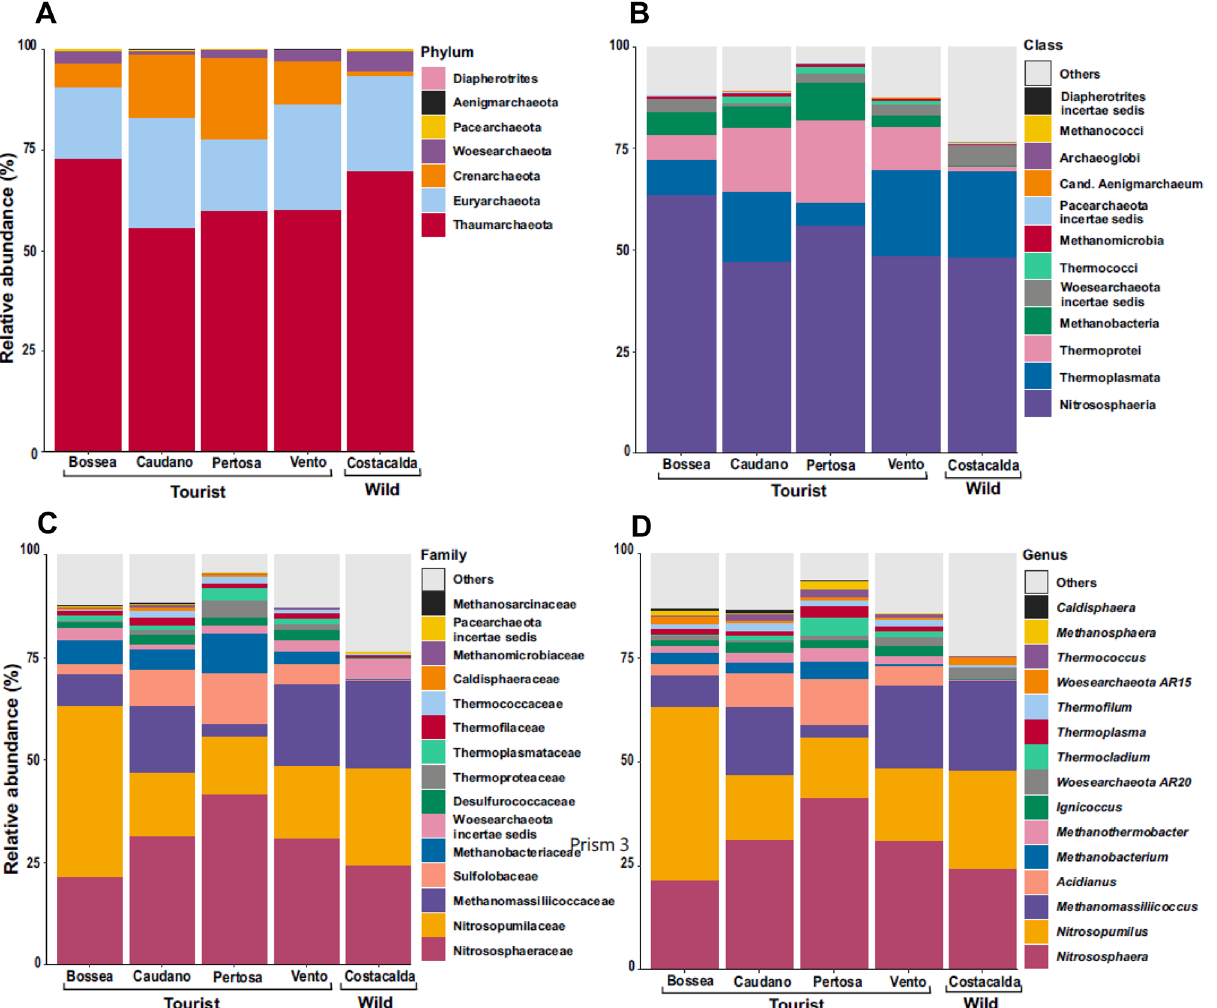
Figure 4. Archaeal community composition of 5 caves studied: Bossea, Caudano Pertosa-Auletta, Vento (show- caves) and Costacalda (wild cave). The top 15 most abundant taxa are shown for taxonomic ranks: phylum ( A ), class ( B ), family ( C ) and genus ( D